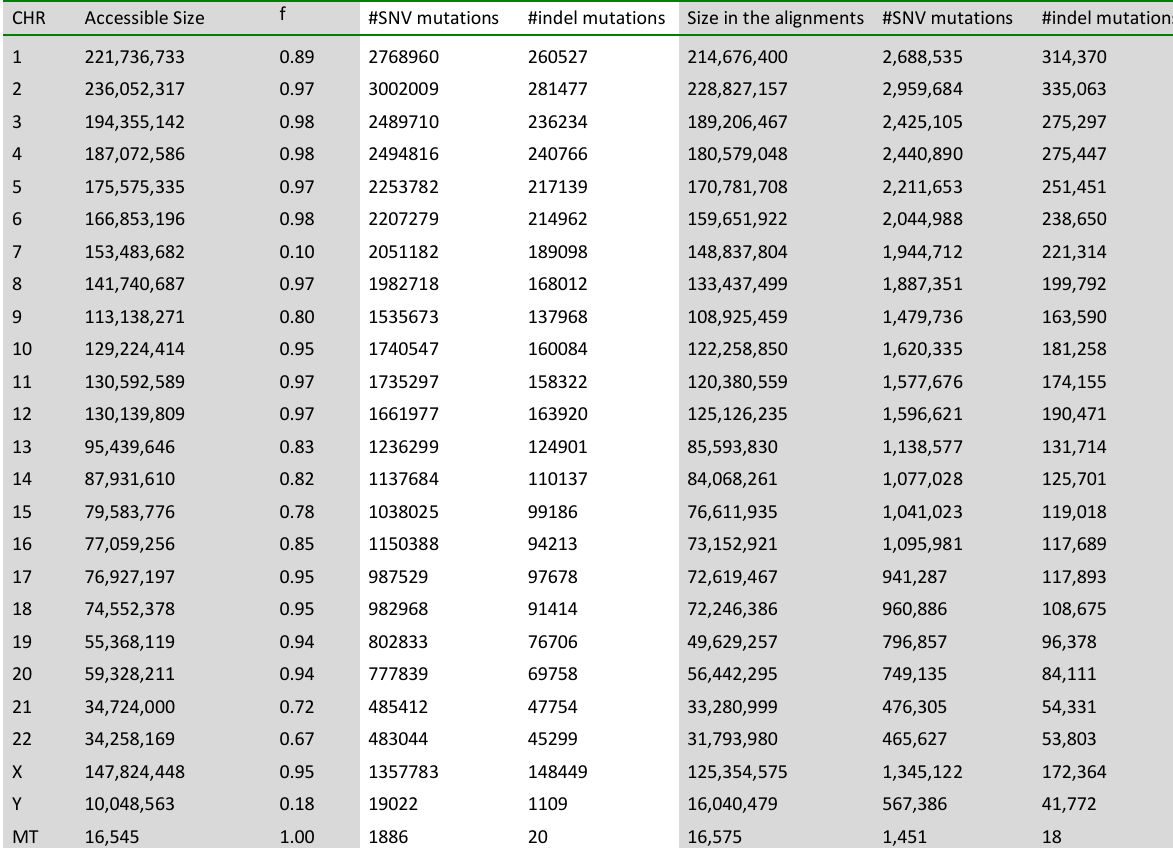
Supplementary Table 1: total number of SNV and indel mutational events for each human chromosome of the 1,000 human genome project phase 3 (white columns) and in the human- chimpanzee genome alignment (gray